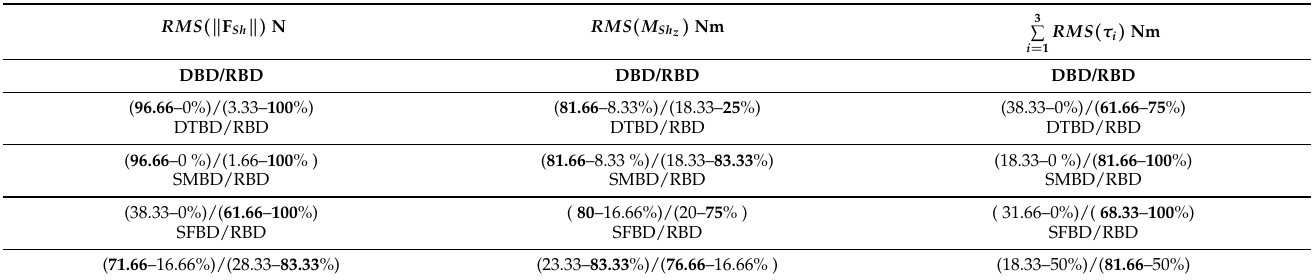
Table 12. Overall performance of the proposed RBD with other design approaches with respect to the indicators presented in Tables